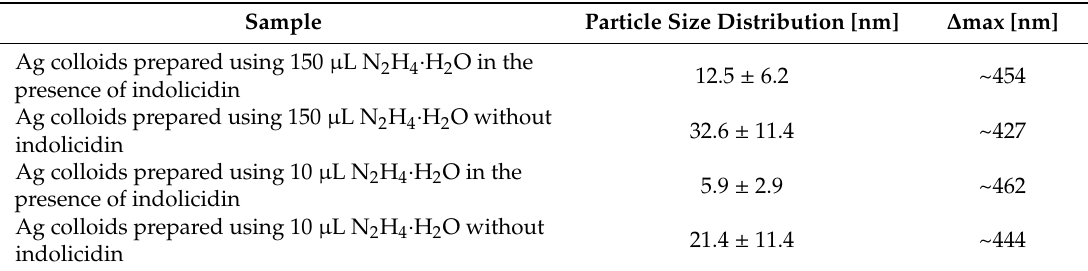
Table 2. Characteristics of Ag colloids prepared with di ff erent amounts of N 2 H 4 · H 2 O, in the presence indolicidin and without the peptide.